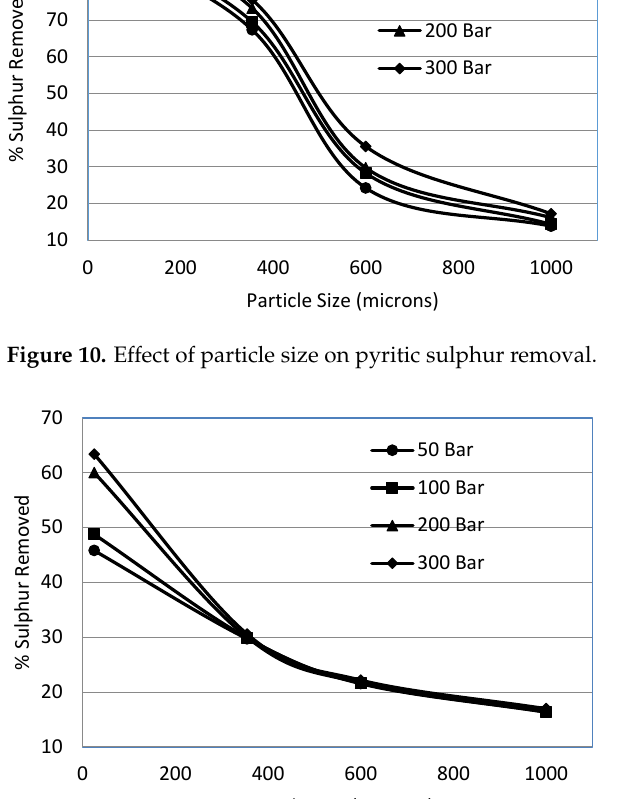
Figure 12. Effect of particle size on heating value recovery.